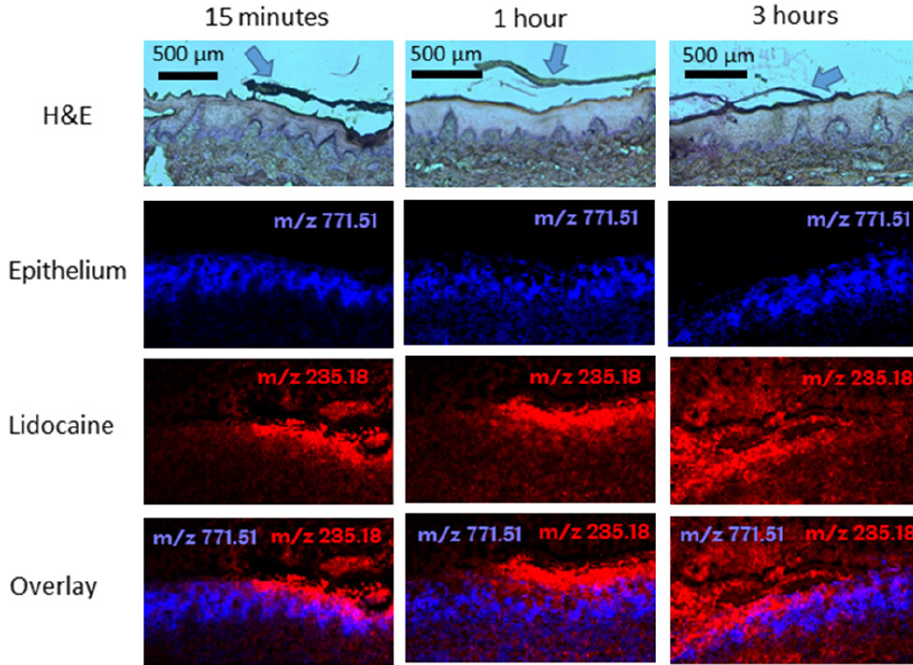
Figure 6. Haematoxylin and eosin (H&E)-stained tissue sections and corresponding MALDI-MS images of porcine buccal mucosa exposed to dual-layer electrospun patches containing 3% (w / v) lidocaine HCl (m / z 235.1805 [M + Na] + ; red) after 15 min, 1, and 3 h. The epithelium (blue) for each sample is shown using the epithelial marker lipid phosphatidylglycerol (34:1) (m / z 771.5140 [M + Na] + ). The arrows in the H&E images show the position of the electrospun patch. Reproduced from [96]. Copyright (2019) Mol. Pharmaceutics 2019, 16 (9), 3948–3956. American Chemical